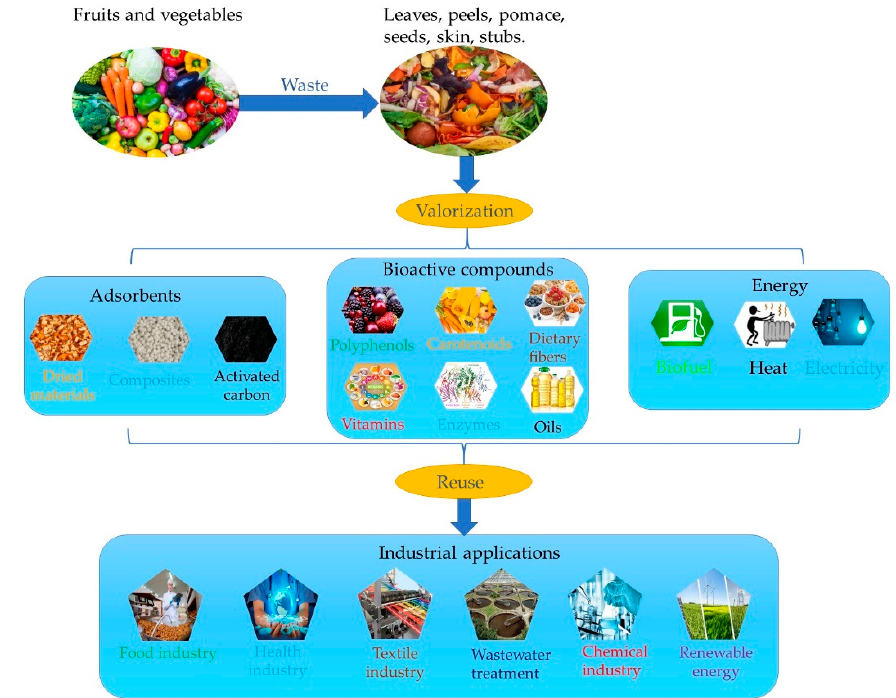
Figure 2. A way to minimize agri-food wastes by their conversion into valuable products.